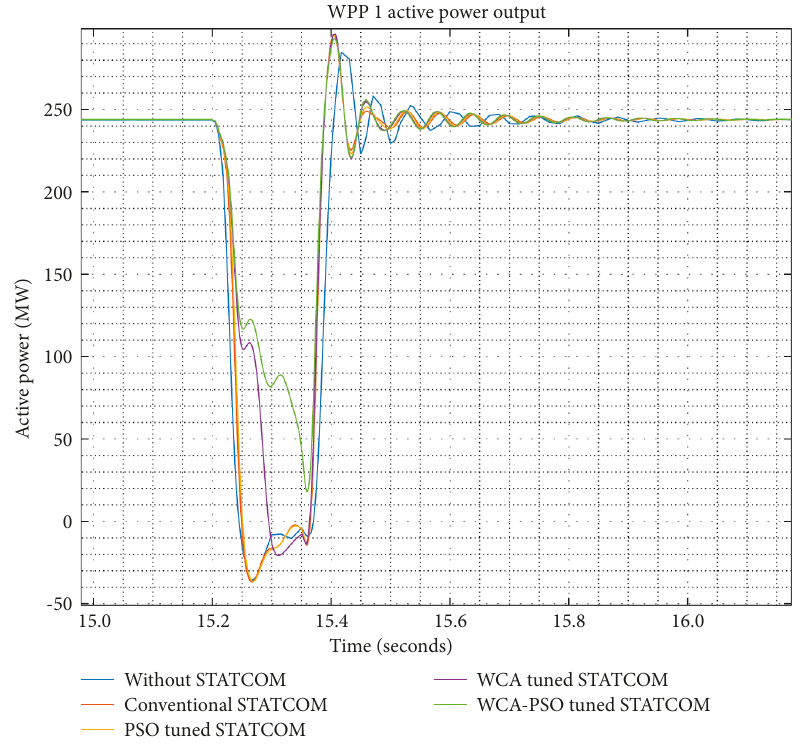
Figure 19: WPP 1 active power output.